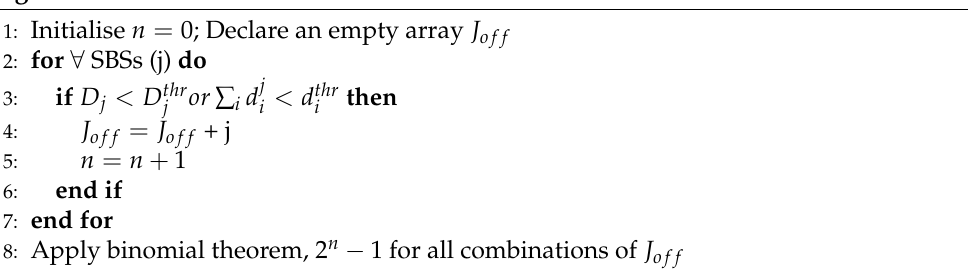
Algorithm 3 Distance-based method.